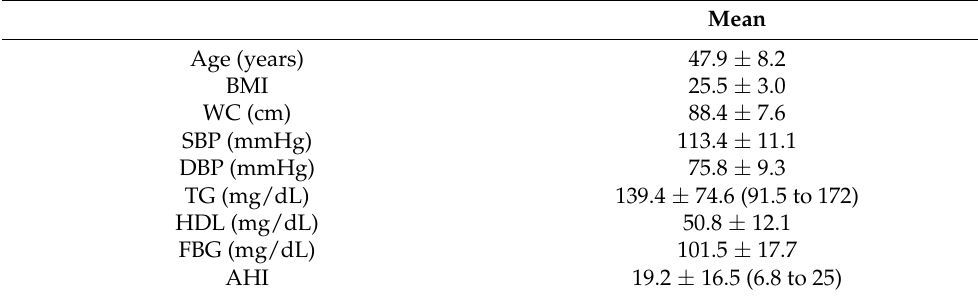
Table 1. Demography of subjects in the